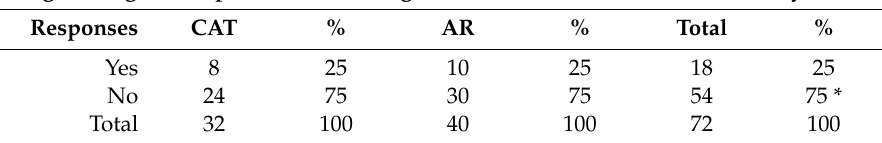
Table 4. Answers obtained in Q2 (source: